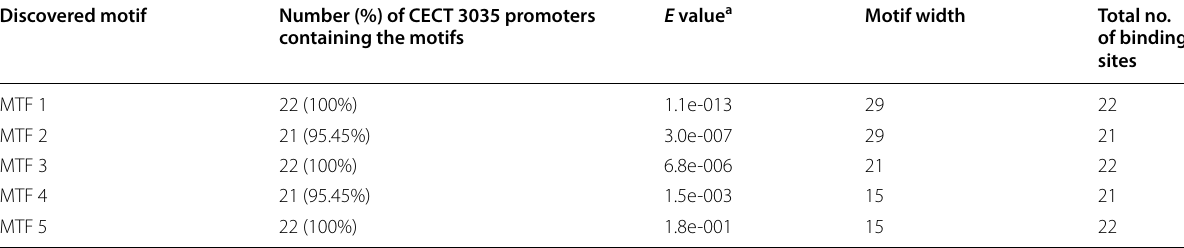
MTF motif a Probability of finding an equally well conserved motif in random sequences